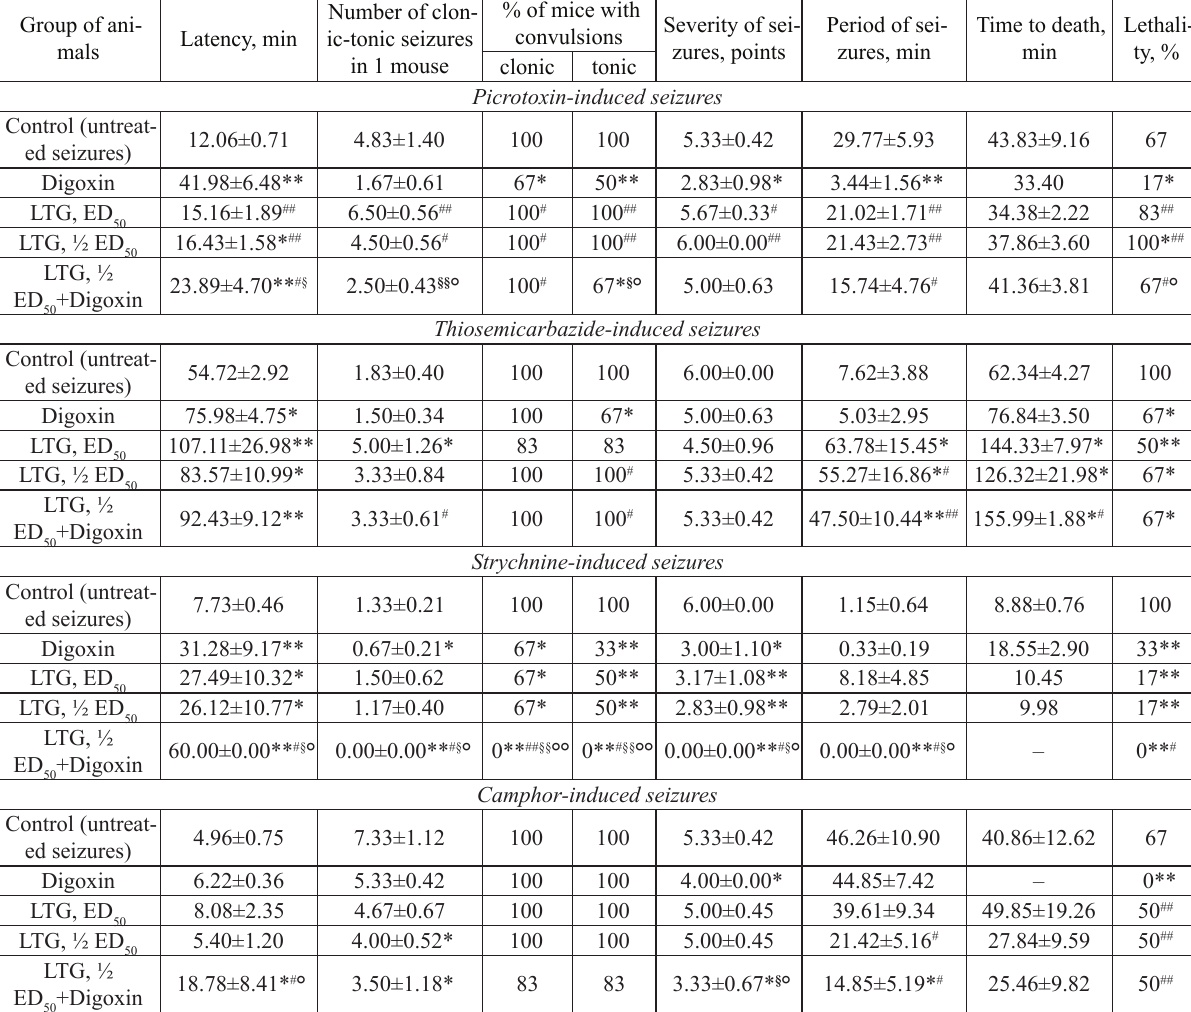
Anticonvulsant effect of digoxin, lamotrigine and their combination in the primary generalized seizures in mice ( n